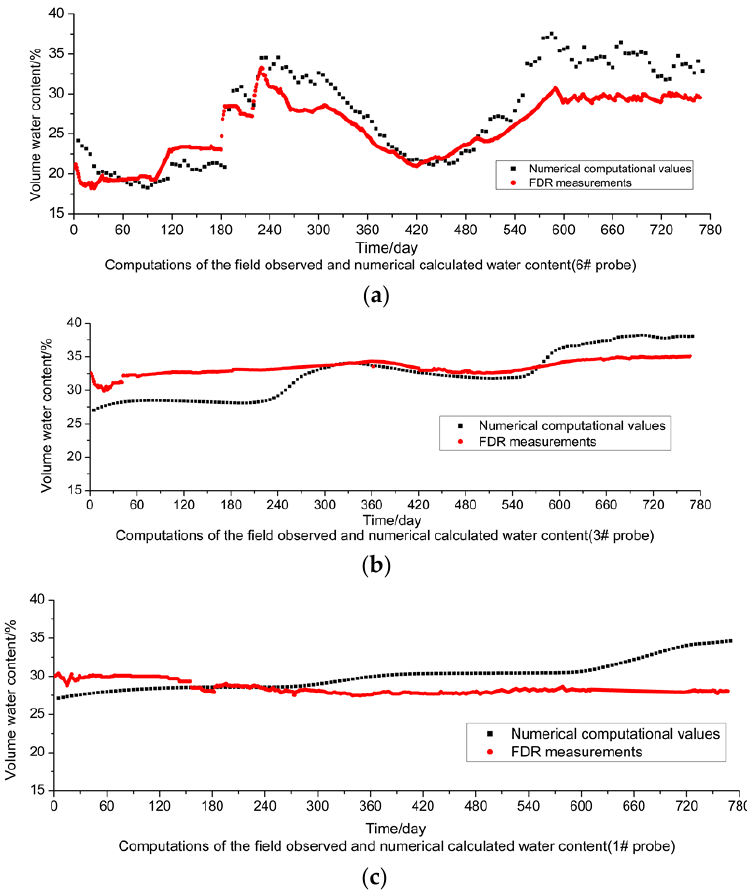
Figure 13. Comparison of measured and calculated volumetric moisture content: ( a ) #6 probe; ( b ) #3 probe; ( c ) #1 probe.